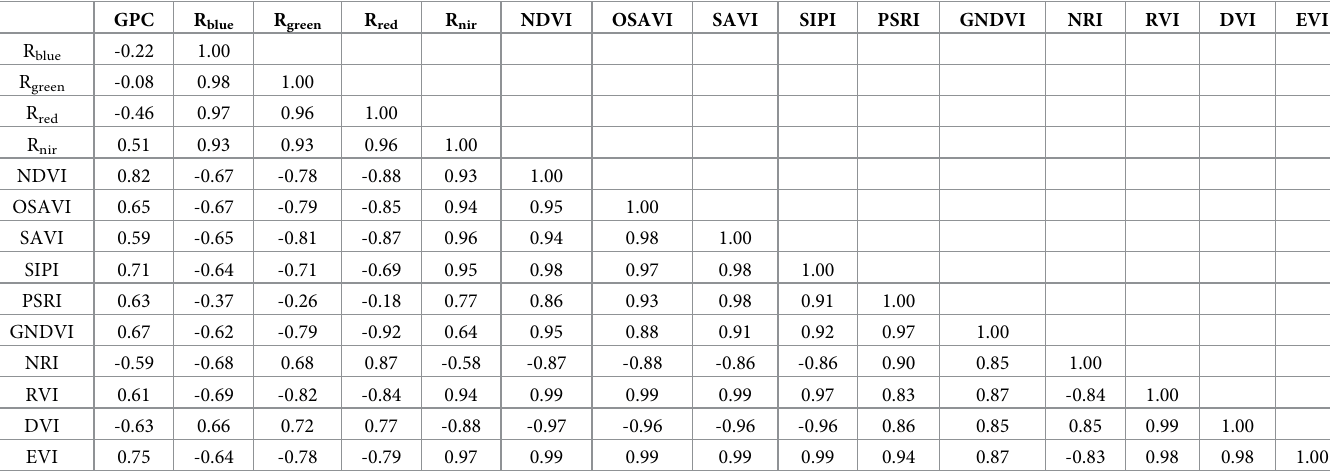
After the PLS model was built, it was used to predict winter wheat GPC. The predicted and measured GPC values were plotted as a 1:1 scatter plot. The optimal linear regression equation and its R 2 and RMSE were obtained. Fig 2 shows the evaluation of the PLS model’s prediction ability. It could be seen from Fig 2 that the model set samples number was larger than the Table 3. Correlation coefficients (r) between remote sensing variables and